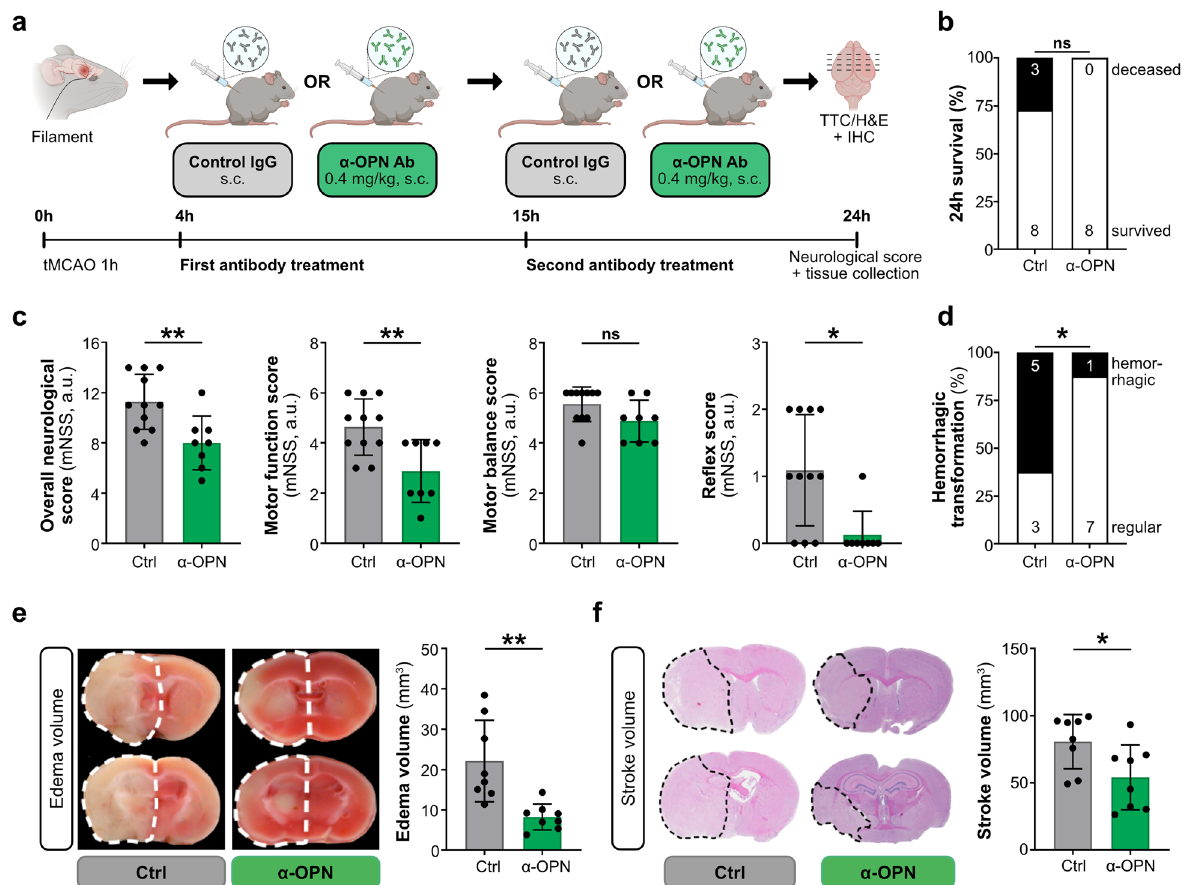
Figure 2. Neutralization of osteopontin during early and late acute phase of ischemic stroke improves neurological outcomes in mice. ( a ) Experimental timeline depicting subcutaneous (s.c.) administration of either 0.4 mg/kg control IgG or anti-osteopontin antibody (α-OPN) 4 h (early acute phase) and 15 h (late acute phase), and assessment of outcome parameters 24 h post-tMCAO. ( b – f ) Outcome parameters assessed 24 h after tMCAO in mice treated with Ctrl IgG or α-OPN antibody. All animals that passed the exclusion criteria were included for the survival and neurological score analysis. For analysis of hemorrhagic transformation, edema and stroke volumes only mice that survived 24 h were included. ( b ) 24 h survival proportion with numbers in histograms indicating animals that died or survived in each group, n = 11 (Ctrl) and n = 8 (α-OPN); not significant (ns) P > 0.05 by Chi-square test. ( c ) Total mNSS including motor balance, motor function and reflexes score, n = 11 (Ctrl) and n = 8 (α-OPN); *P < 0.05, **P < 0.01, and not significant (ns) P > 0.05 by Mann Whitney test. ( d ) Frequency of hemorrhagic transformation of stroke lesions. ( e ) Representative TTC-stained coronal brain slices of Ctrl IgG and α-OPN antibody-treated mice demonstrating edema-induced expansion of ischemic hemispheres as indicated by white dotted line ( e , left panel), and corresponding edema volumes ( e right panel). ( f ) Representative H&E-stained coronal brain slices of Ctrl IgG and α-OPN antibody-treated mice, demonstrating extent of infarction as indicated by black dotted line ( f , left panel) and corresponding stroke volumes ( f , right panel). n = 8 and 8 for Ctrl IgG and α-OPN antibody treatment group, respectively; *P < 0.05, **P < 0.01 by Chi-square test for ( d ), and two-tailed, unpaired t-test for ( e , f Anti‑osteopontin antibody treatment 4 and 15 h post‑tMCAO neutralizes osteopontin and suppresses CD44 receptor expression in NVU cells and improves neurological outcomes in